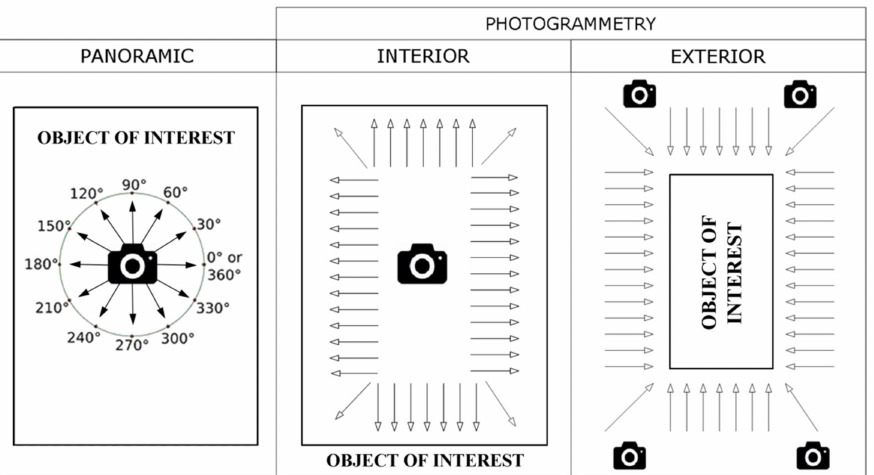
Figure 3. Methodology of photographic acquisition for the interior and exterior photogrammetry and for obtaining the required panoramic